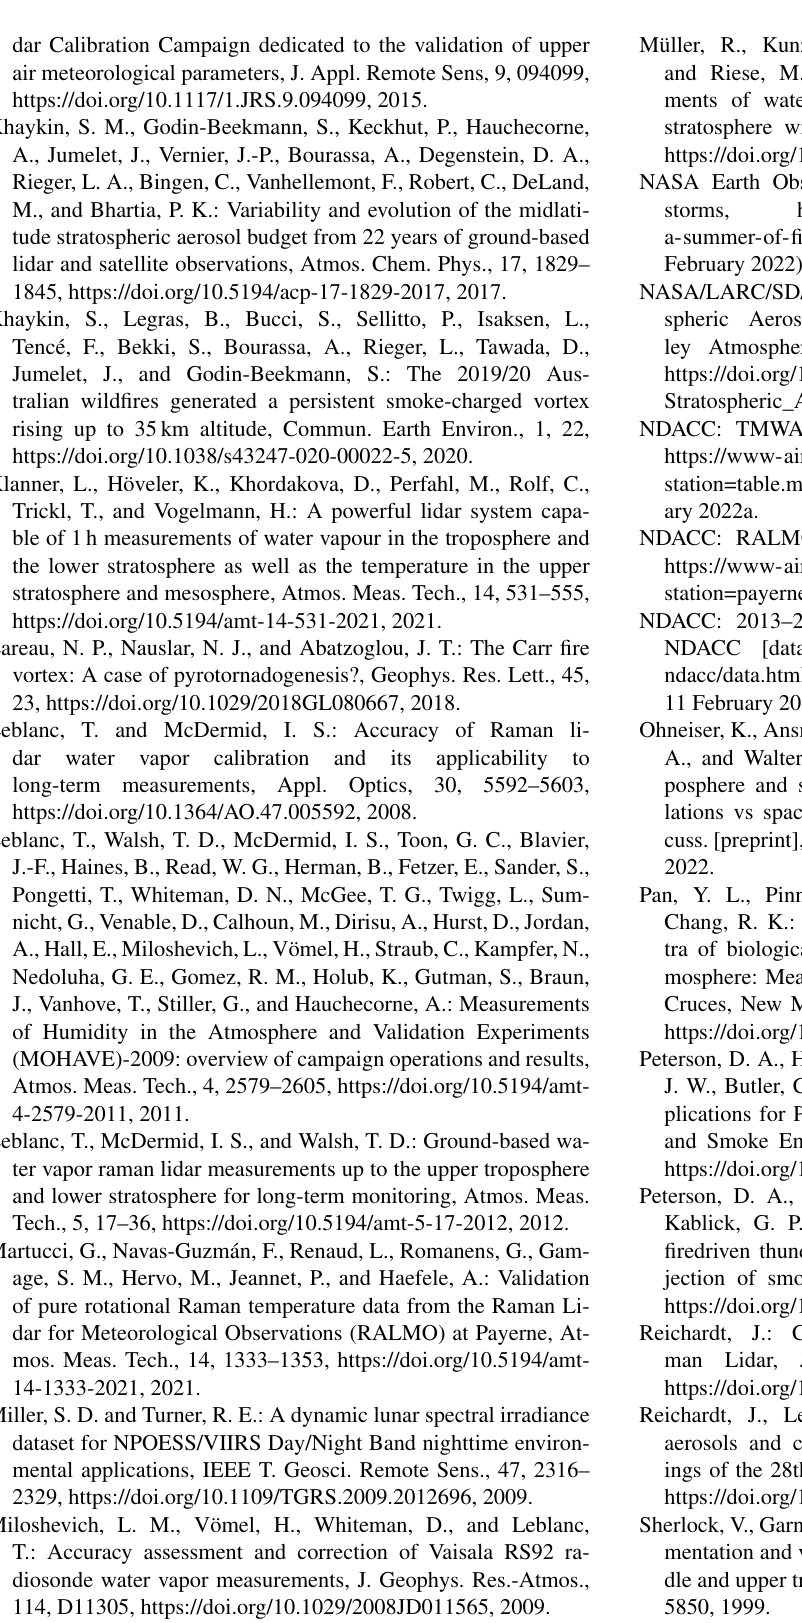
station=table.mountain.ca/hdf/lidar/, last access: 15 Febru- ary